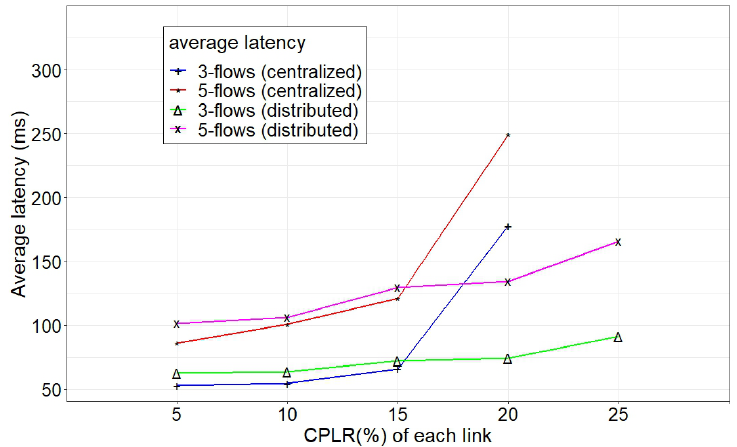
Figure 7. Data plane performance metric (average latency) comparison between centralized and distributed operations, during unreliable control plane conditions in a 16-node grid